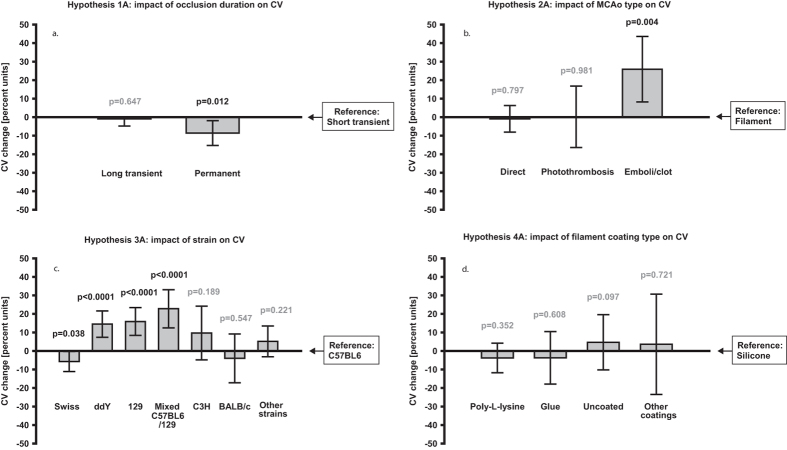
Method parameters’ impact on infarct size variability.Bars represent change in Infarct size coefficient of variation,
measured in absolute percent units. Significant p-values are black,
non-significant p-values are grey. N = 500 for
(a–c) N = 430 for d. Error
bars represent 0.95 confidence intervals.
CV = Coefficient of variation [calculated as
standard deviation/mean]; MCAo = Middle cerebral
artery occlusion.